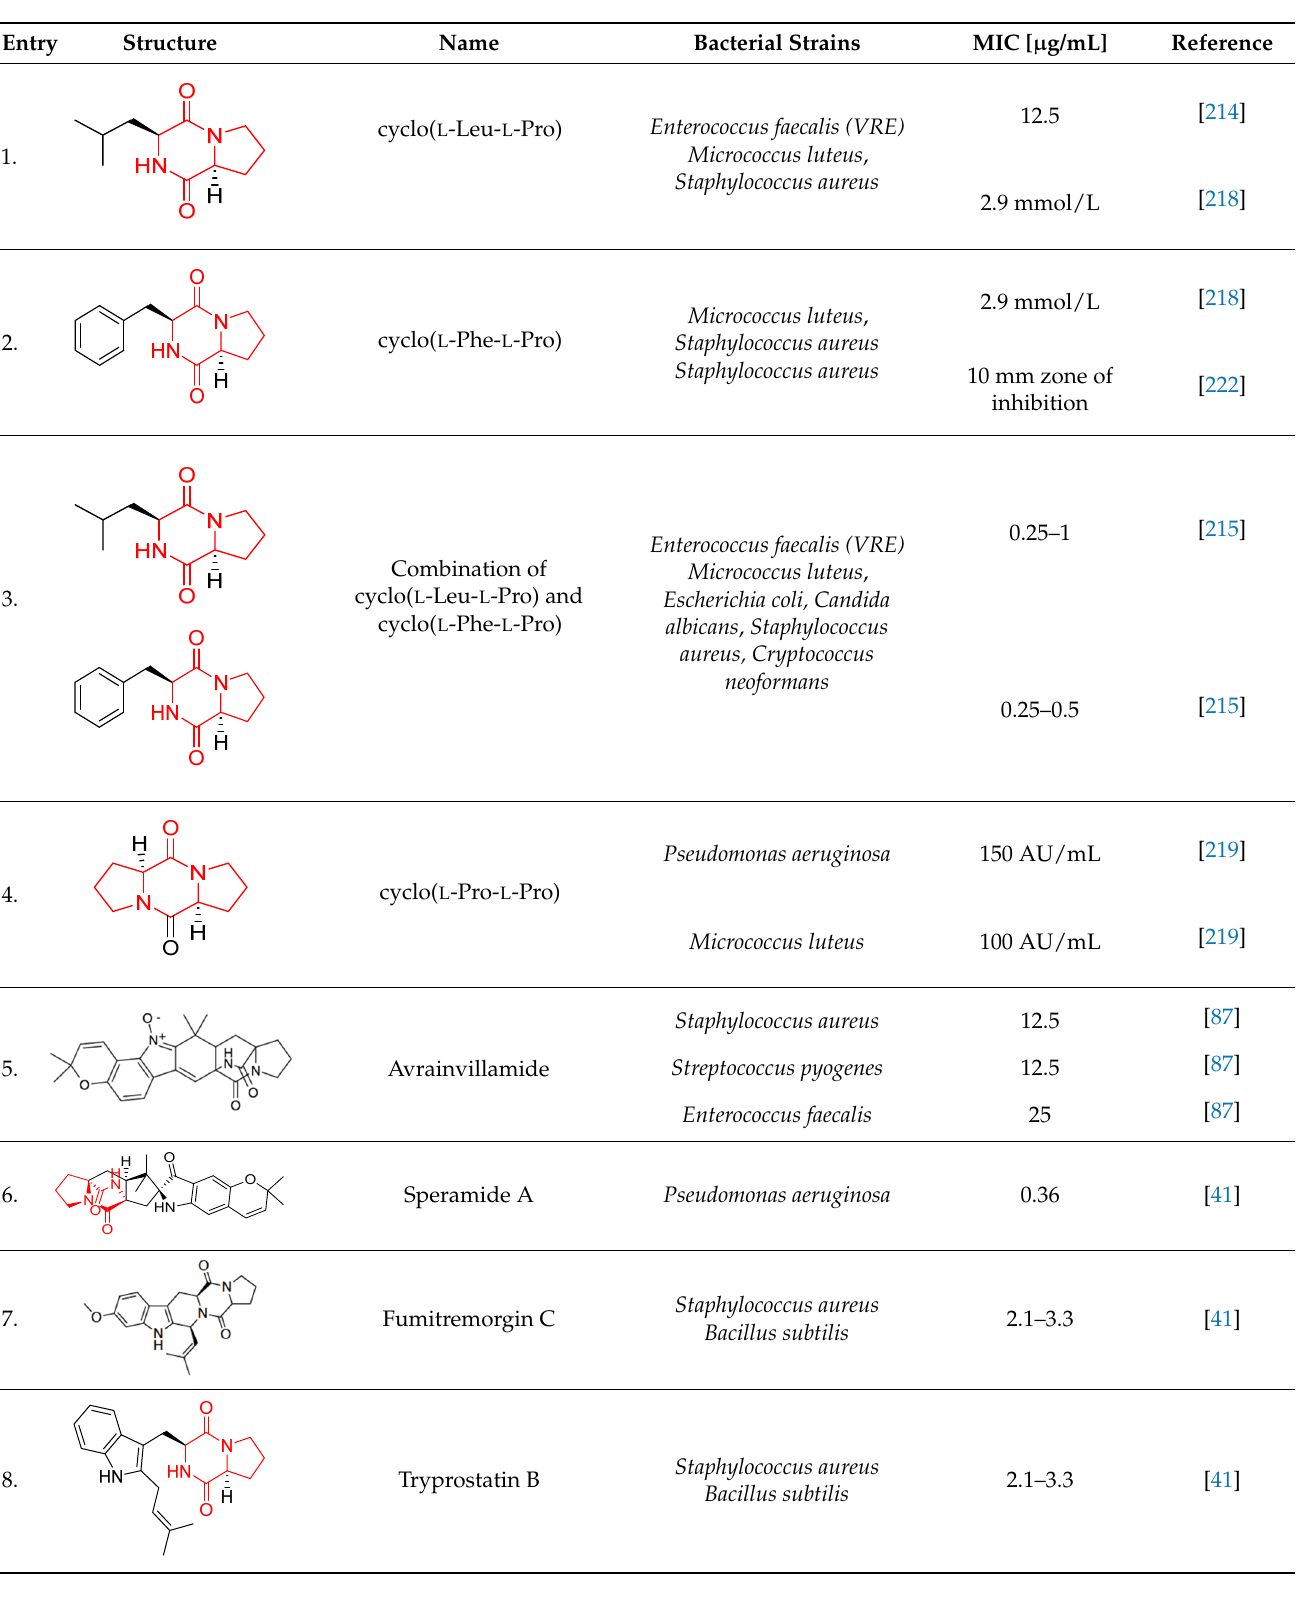
Table 7. Antibacterial